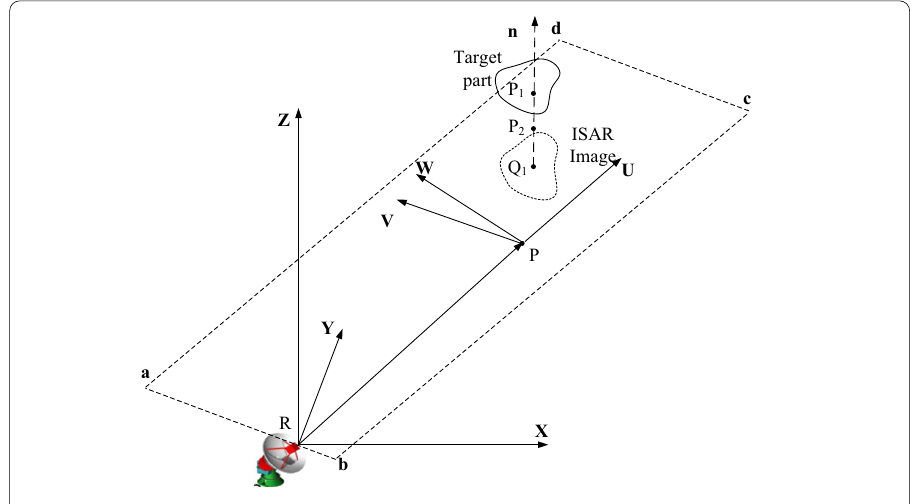
Fig. 1 The geometric model of projection